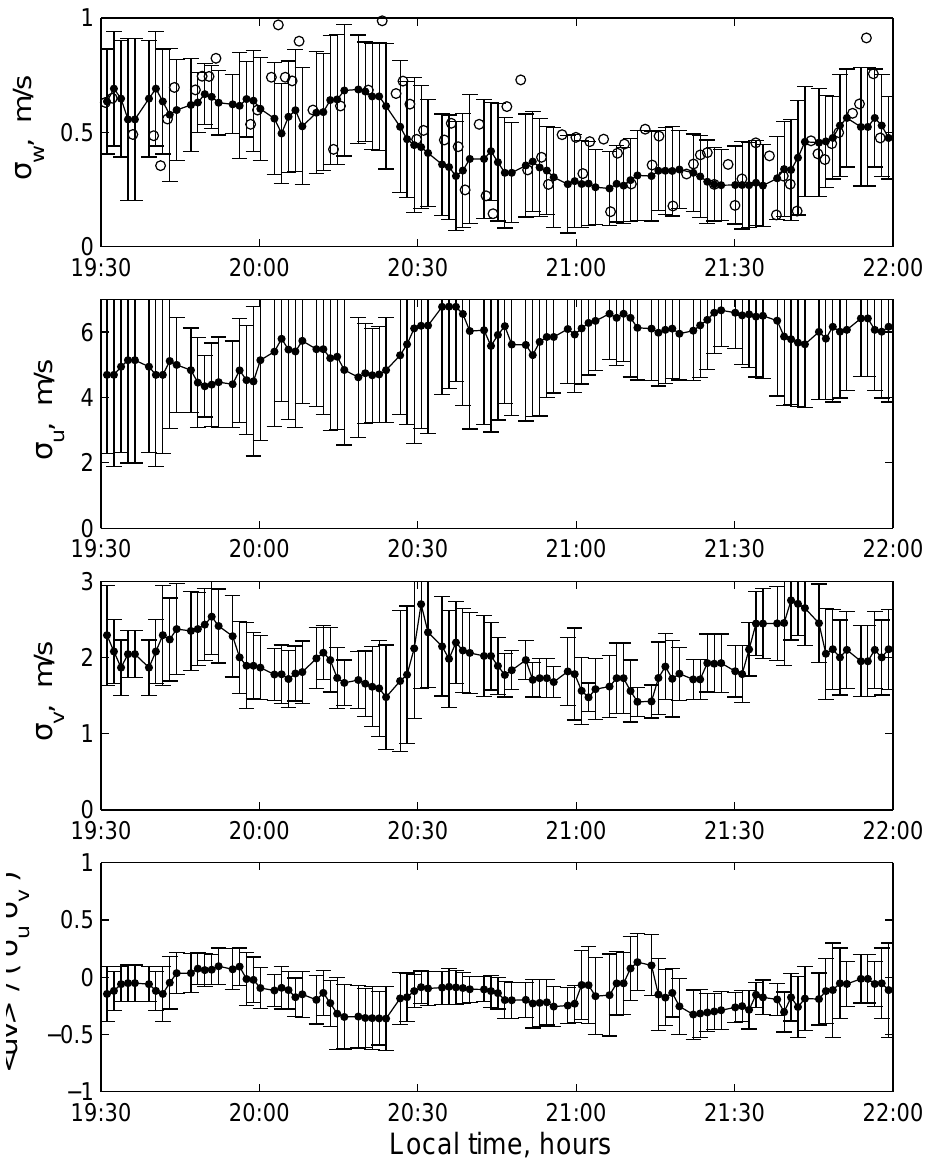
Fig. 9. The same as in Fig. 8 at z o = 10 .